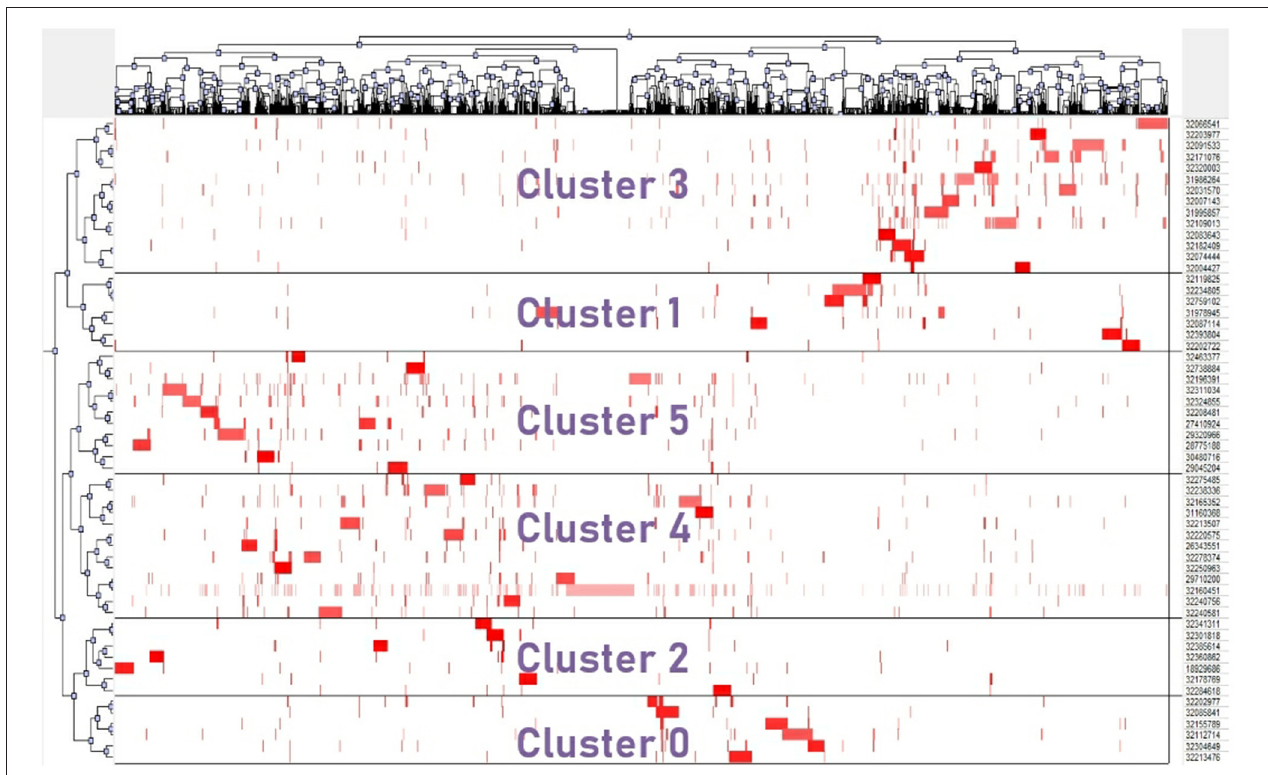
FIGURE 3 | Matrix visualization of bi-clustering of the cited-citing